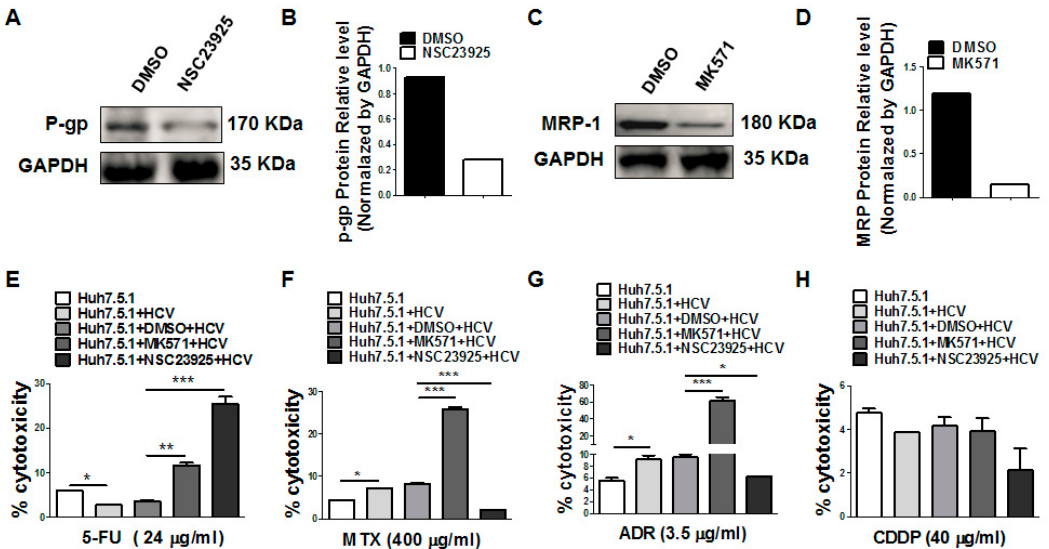
Figure 7. Inhibition of P-gp and MRP1 increased the 5-FU drug sensitivity after HCV infection. ( A , C ) Western blot analysis of P-gp and MRP1 expression in Huh7.5.1 cells in the presence or absence of NSC23925 (P-gp inhibitor) and MK571 (MRP1 inhibitor). Western blot quantification analysis is also listed as ( B , D ). ( E – H ) Analysis of the cytotoxicity of drugs (5-FU / MTX / ADR / CDDP) in HCVcc-infected Huh7.5.1 cells in the presence of P-gp and MRP1 inhibitors.